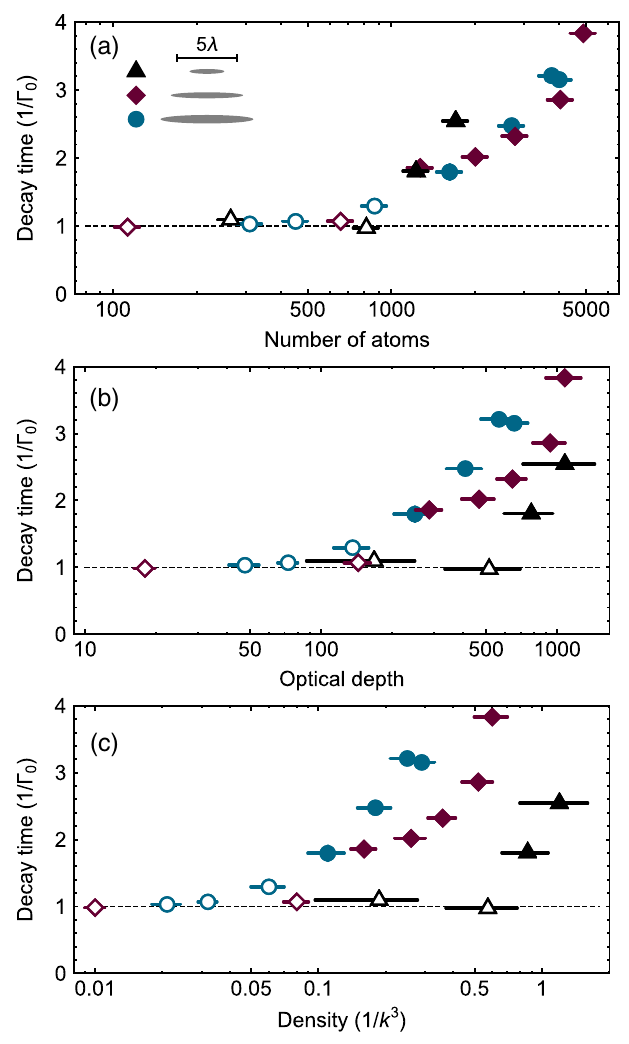
FIG. 2. Decay times in units of the single-atom lifetime Γ − 1 0 evaluated by fitting the traces with a sum of two exponential decays (filled symbols) or with a single one (empty symbols), as explained in the text. The three different data sets are obtained in three different geometries, giving cloud Gaussian sizes ( l , l ): r x ( 0 . 7 λ , 7 . 7 λ ) (circles), ( 0 . 5 λ , 6 . 0 λ ) (diamonds), and ð 0 . 4 λ ; 2 . 9 λ Þ (squares). (a) Experimental data as a function of the atom number. (b,c) Same data plotted as a function of the optical depth b 0 and of the central cloud density ρ 0 . For all the measurements, the ≃ 27 . Error bars on the decay saturation parameter is s ¼ I=I sat time (standard errors from the fit) are smaller than the marker